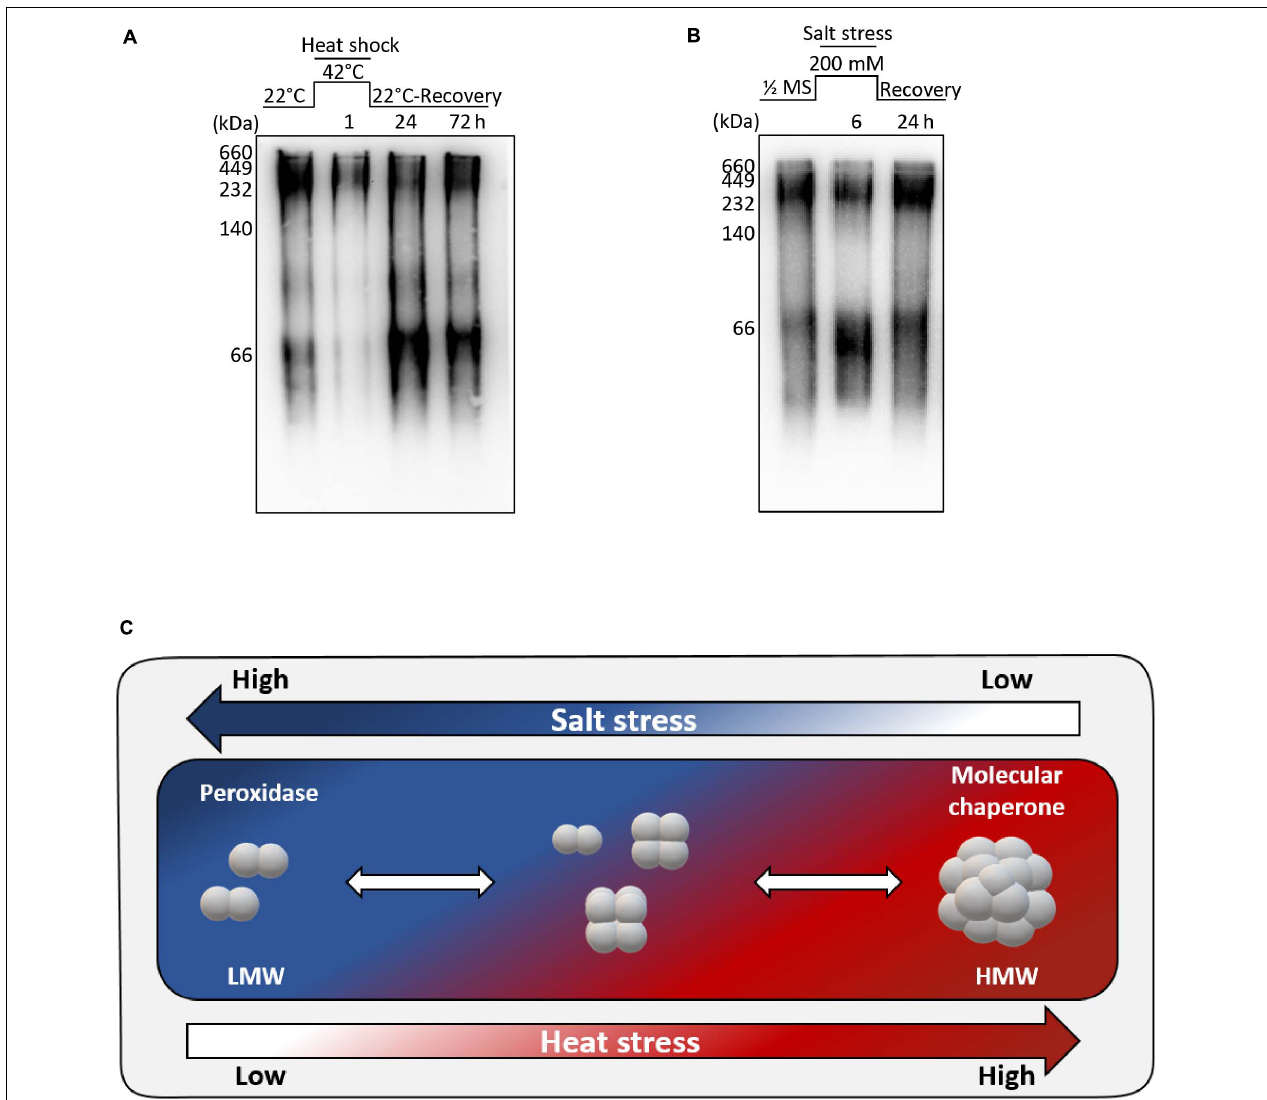
FIGURE 5 | Structural switch in AtAPX1 protein in response to abiotic stress. (A) For heat stress, 10 days old seedlings were subjected to heat stress at 42 ◦ C for 1 h, and then recovered in a growth chamber at 22 ◦ C for 24 h and 72 h. (B) For salt stress, 14 days old seedlings were transferred to 1/2 MS supplemented with 200 mM NaCl for 6 h. For recovery, Arabidopsis seedlings treated with salt stress were transferred to a new 1/2 MS containing no salt and grown for 24 h. (A,B) 20 µ g of total protein was separated on 10% native-PAGE, followed by western blot analysis with an anti-AtAPX1 antibody (1:2,500 dilution). M, marker. (C) Model representation of molecular switching of AtAPX1 in response to abiotic stresses. APX1 in Arabidopsis exists in discretely sized multiple structures with a diverse range of molecular states, including dimeric, LMW, and HMW structures. AtAPX1 protein is converted to dimer or LMW forms under salt stress, whereas it is mainly present in HMW form under heat stress. This reversible switching is accompanied by the change of enzymatic functions of AtAPX1 between peroxidase and molecular